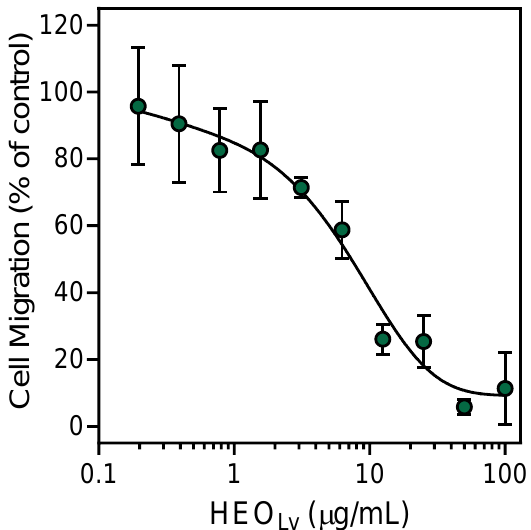
Figure 4. Inhibition of neutrophil chemotaxis by HEO Lv . Neutrophil migration toward 1 nM f MLF was measured, as described in Section 2. The data are presented as the mean ± S.D. (N = 3) from one experiment that is representative of two independent experiments.